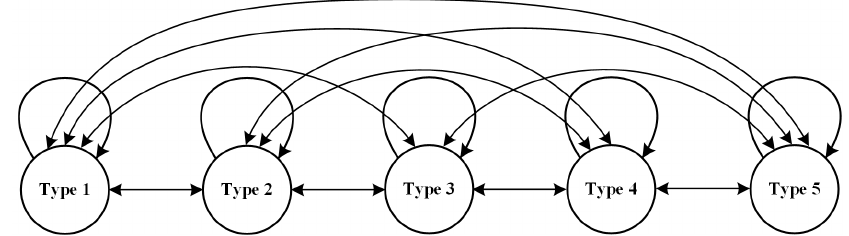
Figure 9. The top-level states belonging to CL (or BU) are fully connected with each other. Each state represents a certain vegetation phenological pattern.